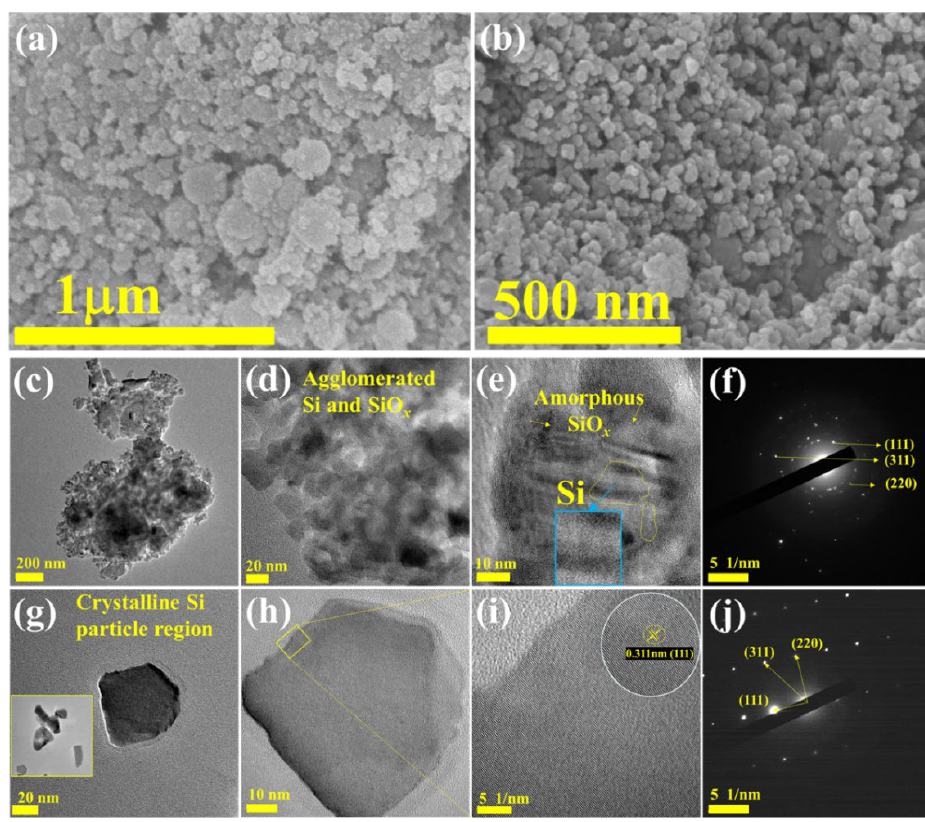
Figure 5. ( a,b ) SEM images of B-Si sample with different magnifications. ( c – e ) HR-TEM images of agglomerated Si/SiO x regions. ( f ) SAED in region of ( e ). ( g – i ) HR-TEM images of crystalline Si-region particle, lattice view, and the corresponding SAED ( j ).